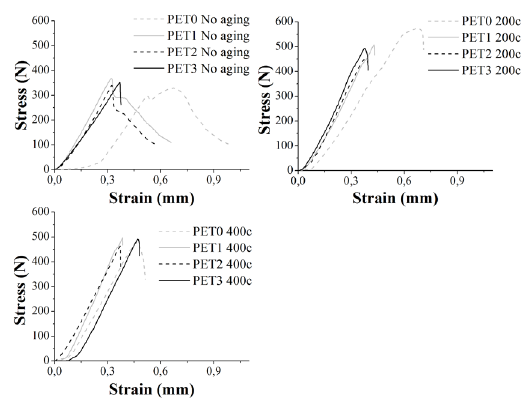
Figure 9. Typical stress vs. strain curves of composites at (a) no aging; (b) after 200 accelerated aging cycles; (c) 400 accelerated aging cycles.